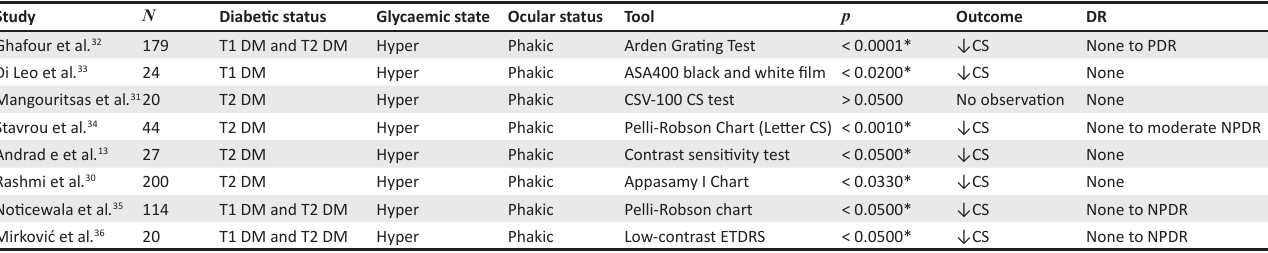
TABLE 4: Effect of glycaemic changes on contrast sensitivity function in people with diabetes mellitus. Study